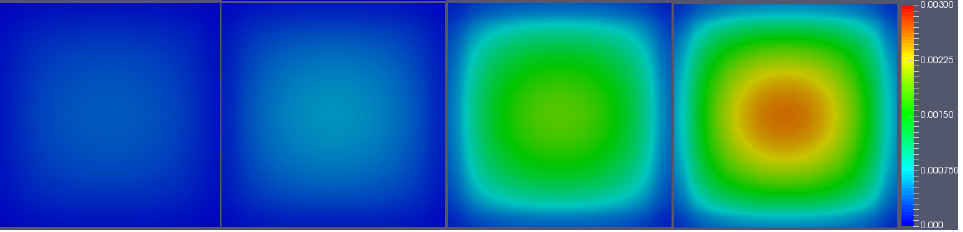
Figure 5. Patterns of carbon monoxide distribution over grain for 8 min, 16 min, 24 min and 32 min.